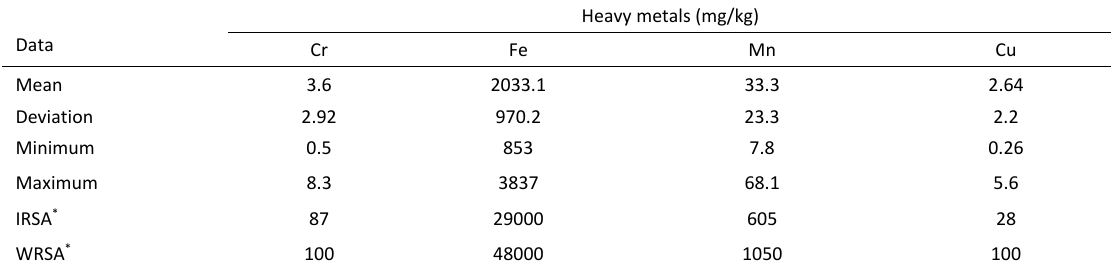
Table 4: Trace metal presence in Tamiraparani river sediment with statistical analysis (Bhaskar et al ., 2016)